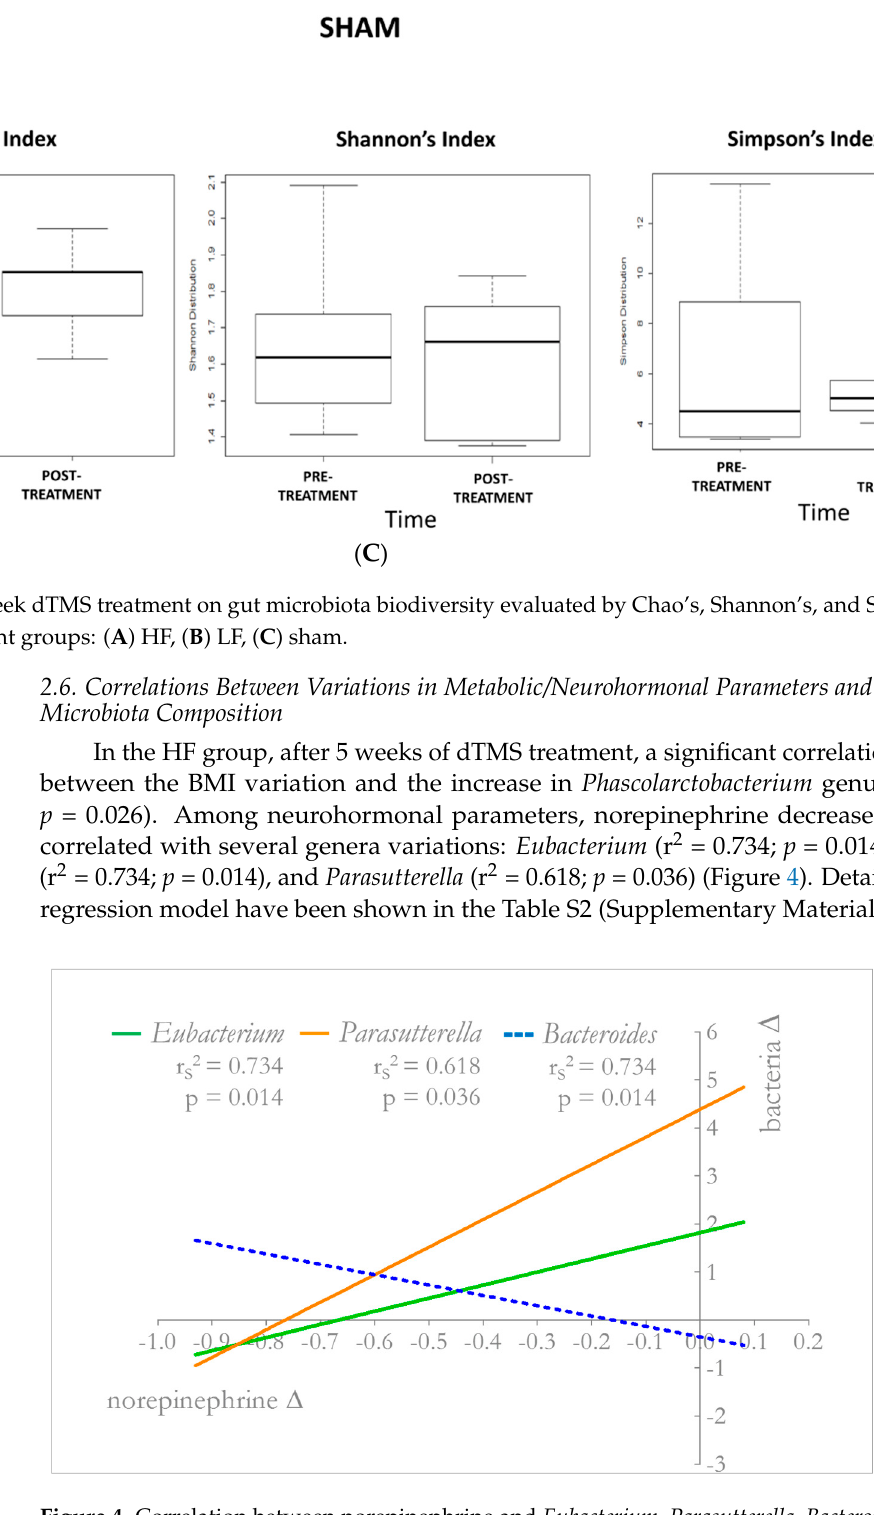
Figure 4. Correlation between norepinephrine and Eubacterium, Parasutterella, Bacteroides abundance variations in HF group. In the HF group, after 5 weeks of dTMS treatment, a significant correlation was found between norepinephrine decrease and several genera variations: Eubacterium (r 2 = 0.734; p = 0.014), Parasutterella (r 2 = 0.618; p = 0.036), and Bacteroides (r 2 = 0.734; p = 0.014). Spearman correlation test and linear regression models were used for finding correlations and relationships among parameters.